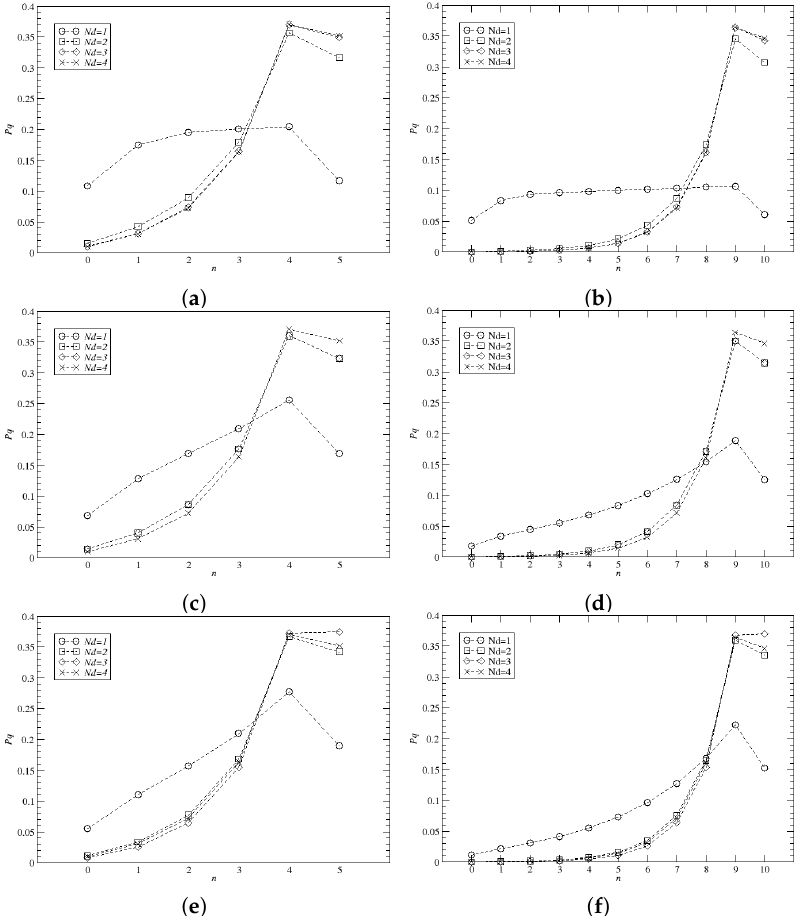
Figure 7. Performance results of the secondary user using a buffer size of 5 ( left column ) and 10 ( right column ) IUs. ( a ) Wl = 0.3, QS = 5. ( b ) Wl = 0.3, QS = 10. ( c ) Wl = 1.0, QS = 5. ( d ) Wl = 1.0, QS = 10. ( e ) Wl = 3.0, QS = 5. ( f ) Wl = 3.0, QS =